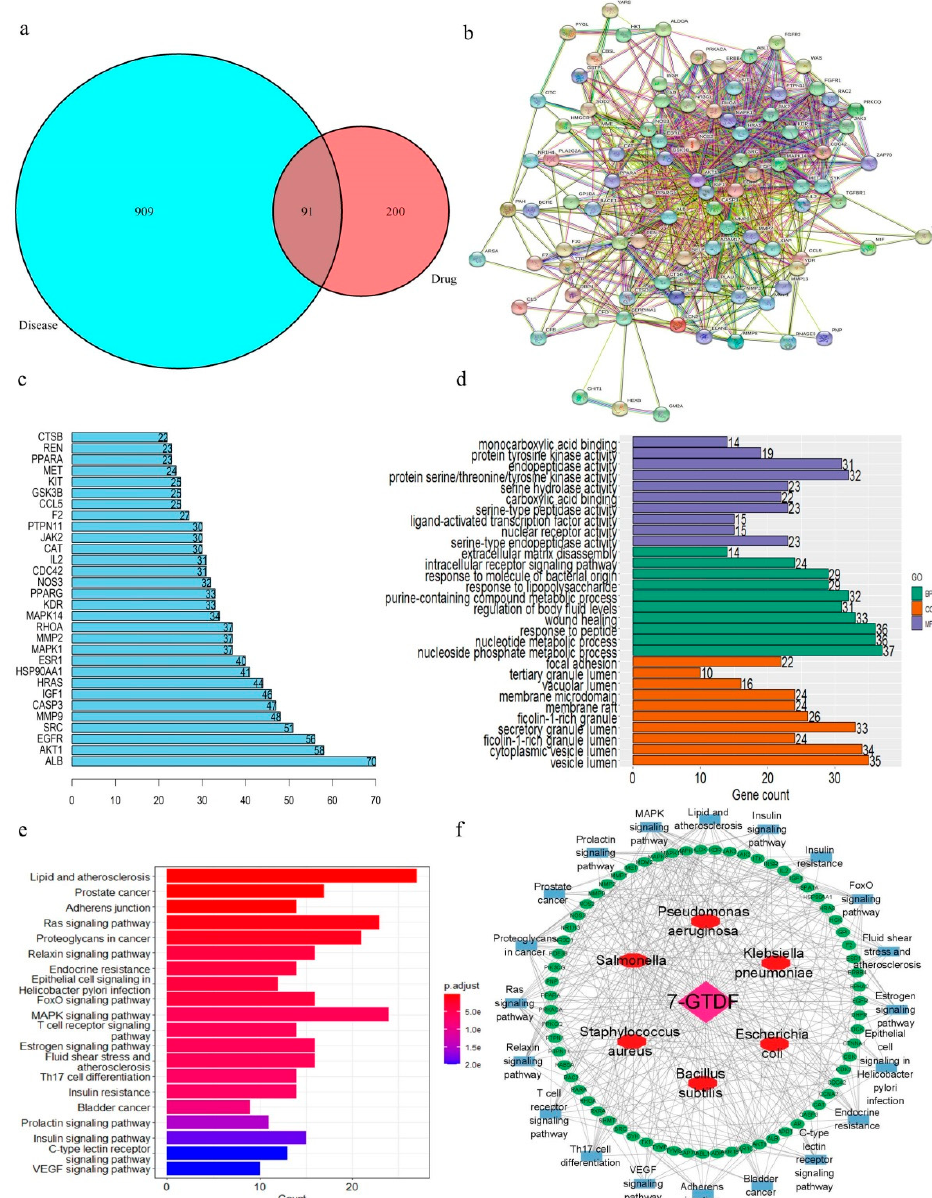
Figure 7. Prediction and analysis of the antibacterial mechanism of 7-O-galloyltricetiflavan. ( a ) Venn diagram of differential chemical markers and intersection targets; ( b ) PPI network; ( c ) node degree bar plot; ( d ) GO functional enrichment analysis; ( e ) KEGG pathway enrichment analysis; ( f ) component–target–pathway–disease network.